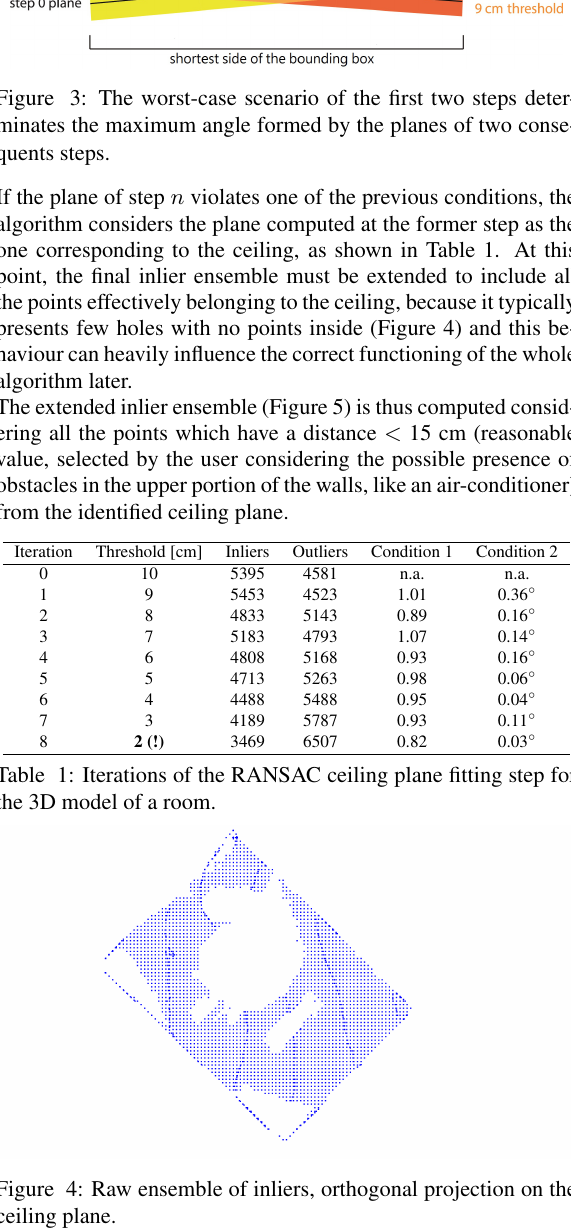
Figure 5: Extended inliers ensemble, orthogonal projection on the ceiling plane.